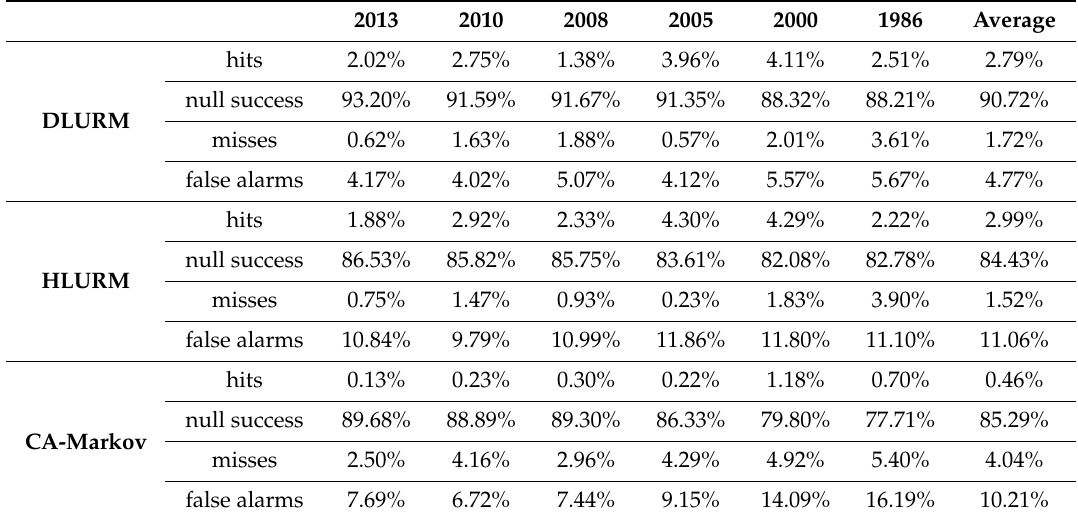
Table 4. Prediction correctness and error (Appendix